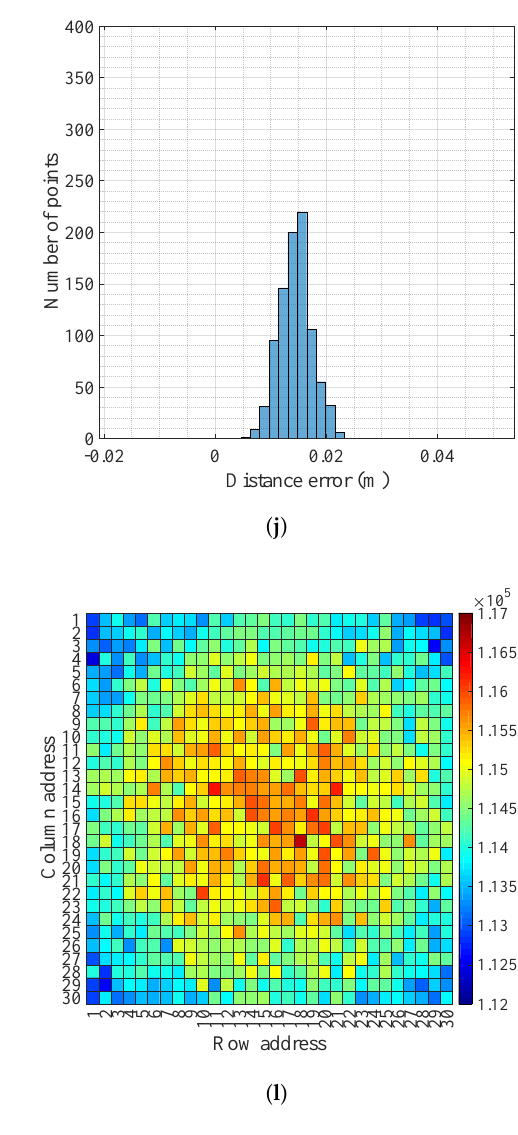
Figure 9. Images of the white paper wall 10m in front of the LIDAR system: ( a ) distance map and ( b ) histogram of distance in the ground truth; ( c ) distance map and ( d ) histogram of distance in the legacy mode; ( e ) distance map and ( f ) histogram of distance in the OCDMA mode; ( g ) distance error map and ( h ) histogram of distance error in the legacy mode; ( i ) distance error map and ( j ) histogram of distance error in the OCDMA mode; ( k ) intensity map in the legacy mode; ( l ) intensity map in the OCDMA